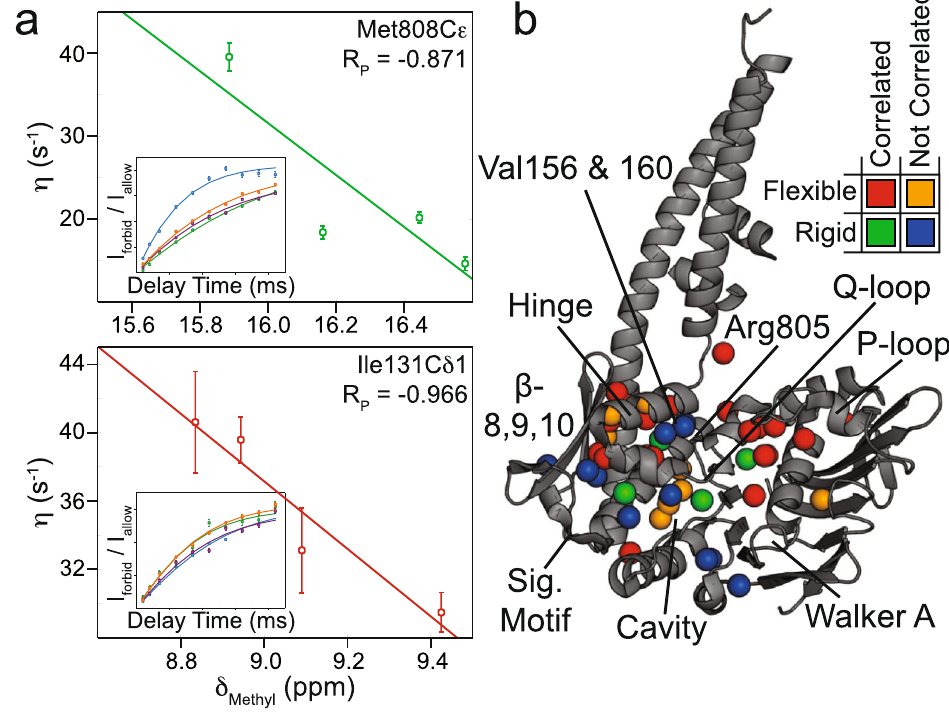
Figure 3. Chemical shift perturbations and dynamics changes are correlated. ( a ) Representative η vs δ Methyl scatter plots for Met808C ε ( top ) and Ile131C δ 1 ( bottom ). δ Methyl values were determined according to equation (1), see Supporting Information. Pearson’s correlation coefficients (R P ) are given in the upper right corner. Insets show the build-up curves for the ratio of intensities arising from methyl group 1 H triple-quantum “forbidden” experiments 36 (I forbid /I allow ) vs . relaxation delay time for wildtype and mutant Mre11 HLH -ILVM labeled Rad50 NBD . These data were fit to equation (3) to determine the η rates 36 , as described in the Methods, with errors determined from the covariance matrix of the fit 48 . The coloring of the curves corresponds to the spectra of the mutants in Fig. 2a. ( b ) Structure of Mre11 HLH -Rad50 NBD showing side chain methyl groups with altered dynamics upon mutation. Red and orange spheres represent methyl groups that become more flexible upon mutation, whereas green and blue spheres represent methyl groups that become more rigid upon mutation. Red and green coloring denotes “Correlated” methyl groups with significant CSPs upon mutation (i.e., the range in δ Methyl > 0.13 ppm) that also have a correlation for η vs δ Methyl of |R P | > 0.7. Orange and blue coloring denotes “Not Correlated” methyl groups with small CSPs upon mutation (i.e., the range in δ Methyl < 0.13 ppm) but have a large difference in η rates between wildtype and the mutants (| η WT – the average η mutants | > 8 sec − 1